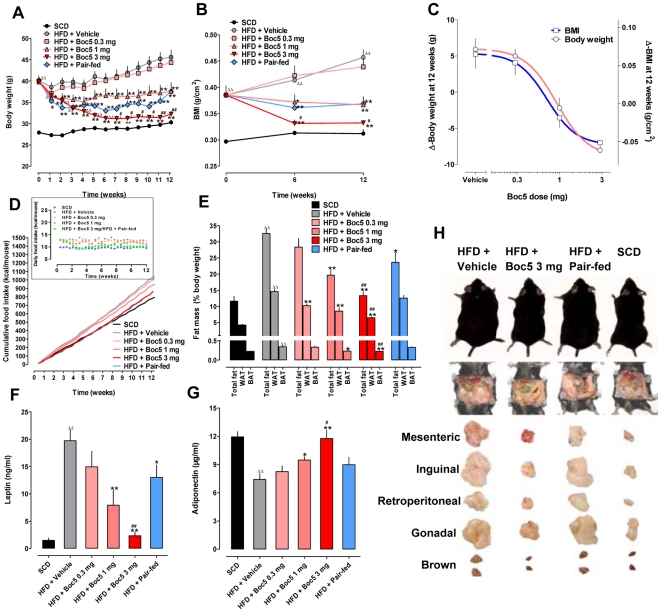
Effects of Boc5 on body weight, BMI, food intake, adiposity and circulating adipocytokine concentrations.(A) Time course of the effect on body weight (n = 16 per group). (B) BMI monitored before, during and after the treatment (n = 6 per group). (C) Dose-response profiles for weight (Δ-body weight) and BMI (Δ-BMI) changes over the 12-week period (n = 16 per group for weight and n = 6 per group for BMI). (D) Time course of the effect on cumulative and daily food intake (insert) (n = 16 per group). (E) Dose-dependent effects on whole fat mass (n = 6 per group), white and brown adipose tissues (WAT and BAT) as percentage of body weight (n = 8–14 per group). WAT were represented by mesenteric, inguinal, retroperitoneal and gonadal fat pads. (F) Serum leptin and (G) adiponectin levels measured at the end of the treatment (n = 9 for SCD and HFD groups; n = 6 for Boc5-treated groups). (H) Effects on the gross appearance of body shape (upper panel), abdominal fat (middle panel) and fat depots (lower panel) recorded at autopsy. Values represent mean±SEM. Δ
P<0.05 and ΔΔ
P<0.01 compared with SCD group; *
P<0.05 and **
P<0.01 compared with HFD group; #
P<0.05 and ##
P<0.01 compared with pair-fed group that received an equal amount of food as 3 mg Boc5-treated mice.